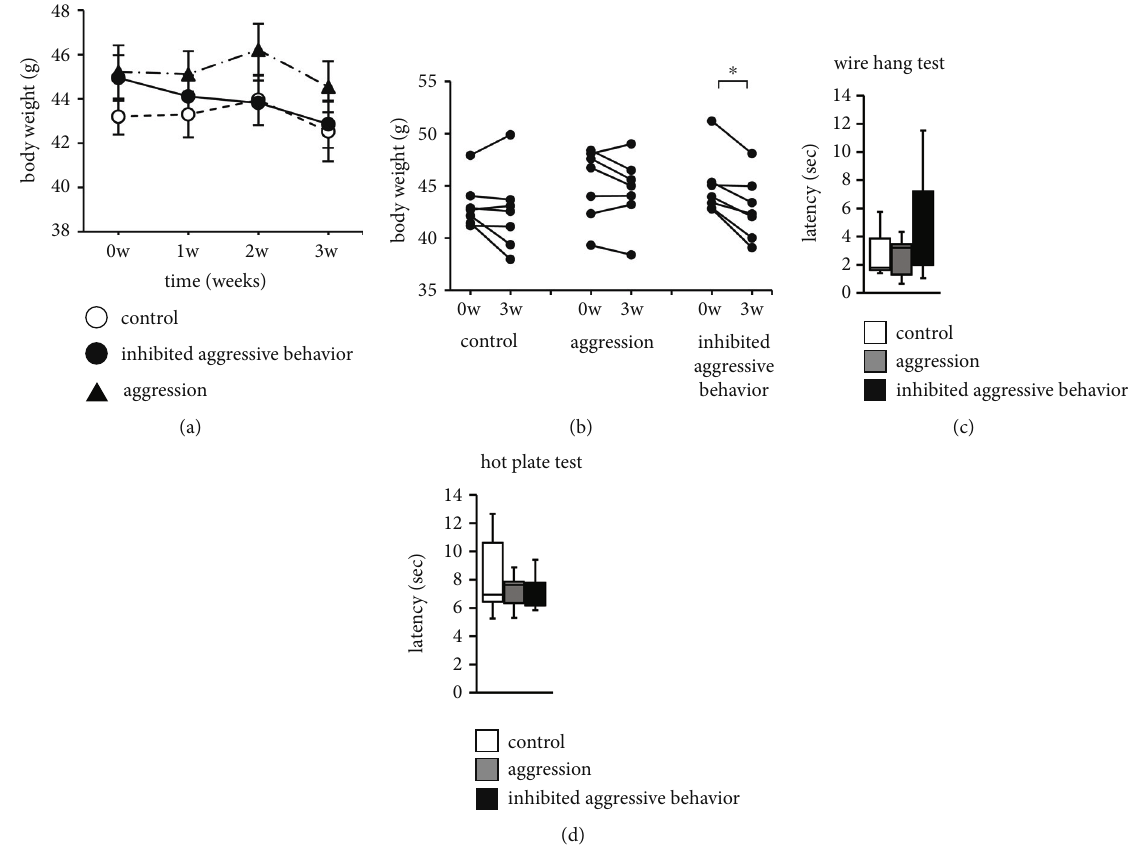
Figure 2: Physical characteristics of the aggressive behavior-inhibited mice. (a) Body weights of mice are weighed weekly for 3 weeks. (b) Individual results of the body weight change for 3 weeks. (c) Latency to fall in the wire hang test. (d) Hot plate test results. Data are presented as mean ± standard error (a) or box plots (c) and (d). * p < 0 : 05 and + p < 0 : 1 . (a) – (d) control group: n = 7 , aggression group: n = 7 , and inhibited aggressive behavior group: n = 7